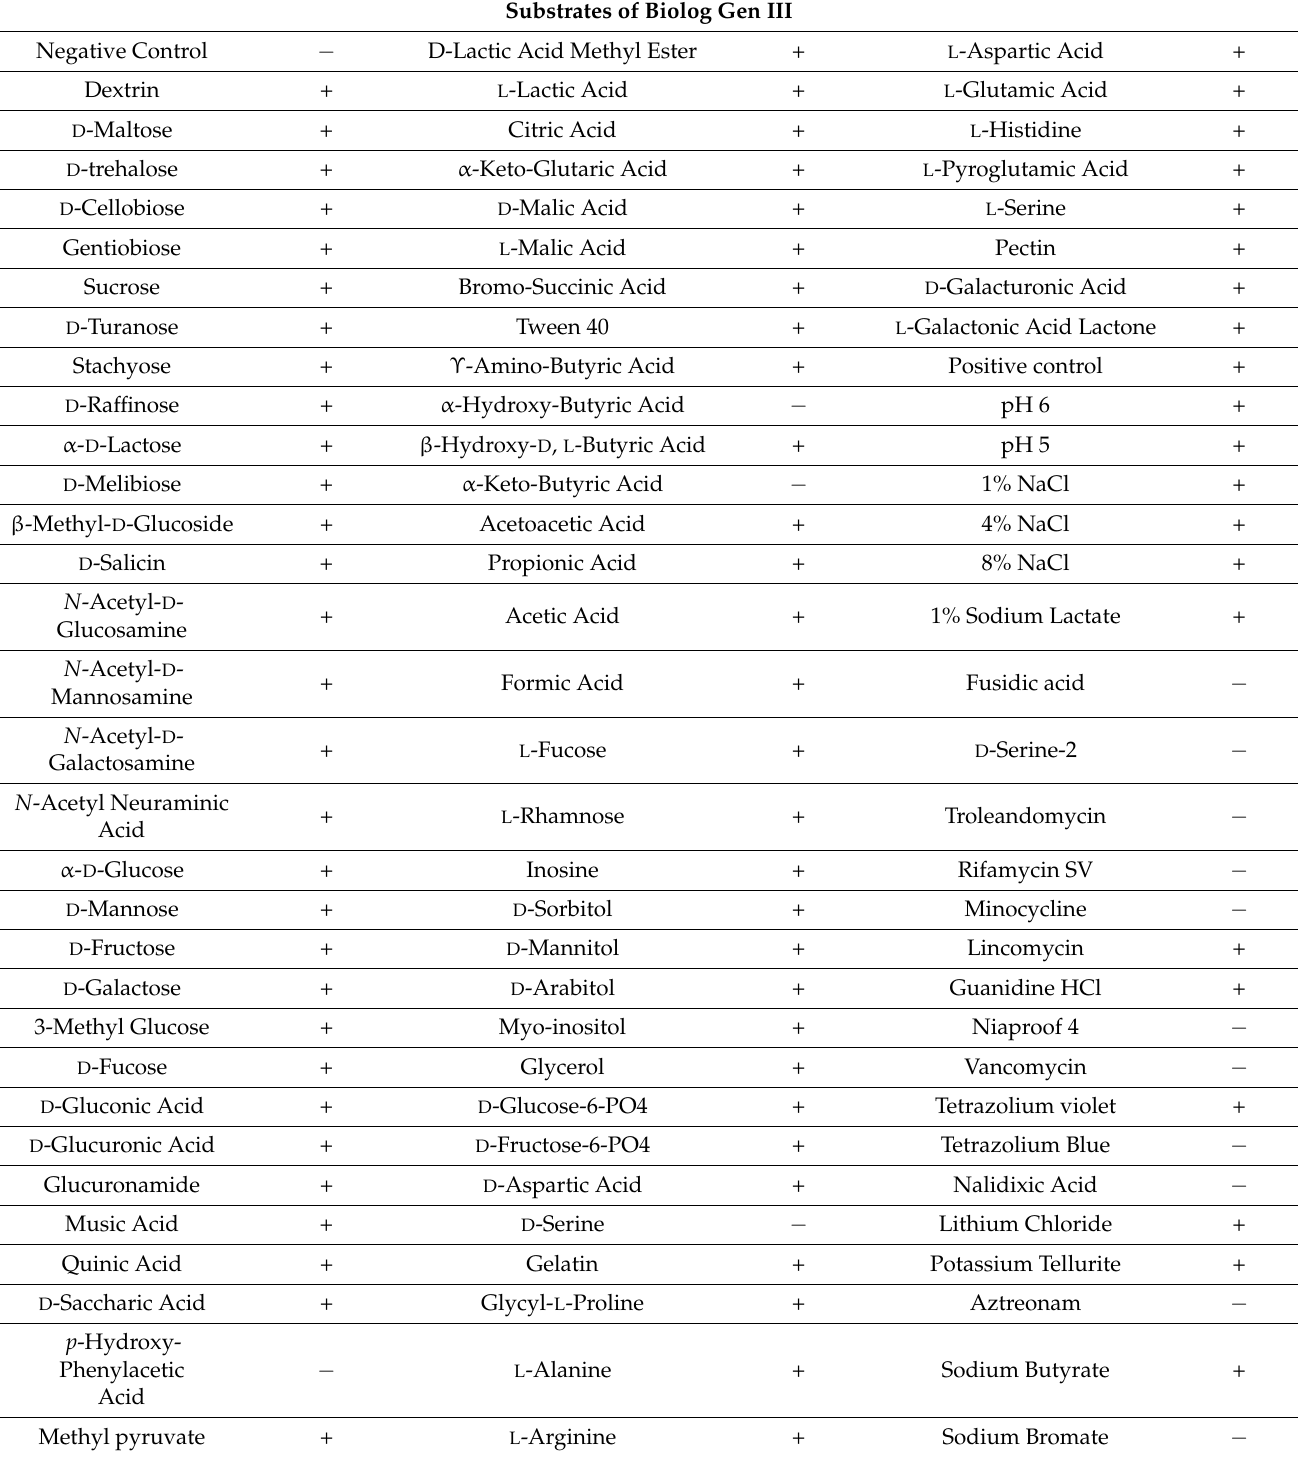
Table 5. Metabolic profile of B25 on Biolog GEN III microplate: (+) growth, ( − ) no growth. Substrates of Biolog Gen